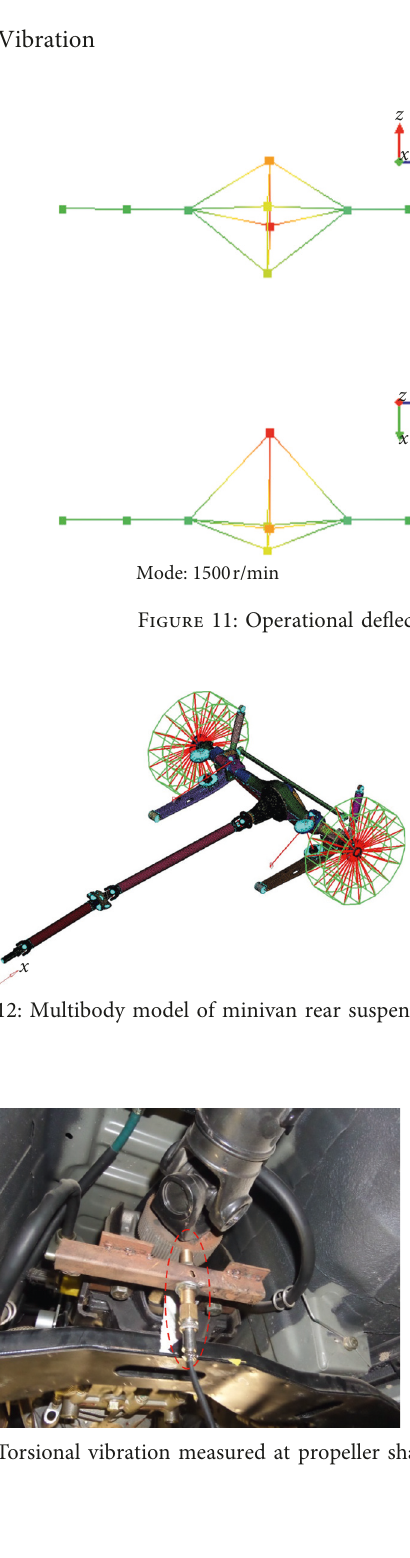
Table 4: Sensors used in torsional vibration test.